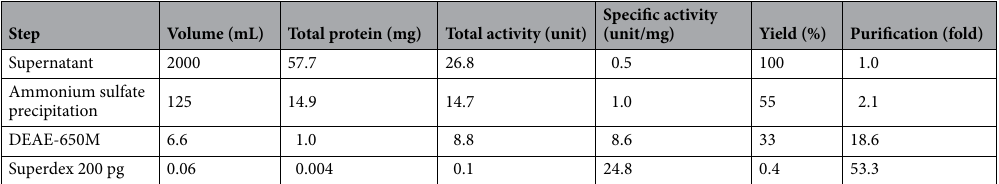
Table 1. Summary of G. adiacens HA lyase